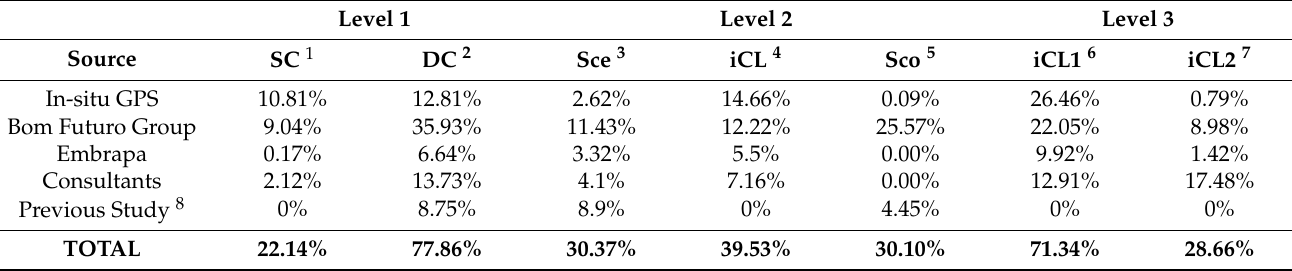
Table 1. Source and number of field samples (training/validation database) for all classes and levels. Level